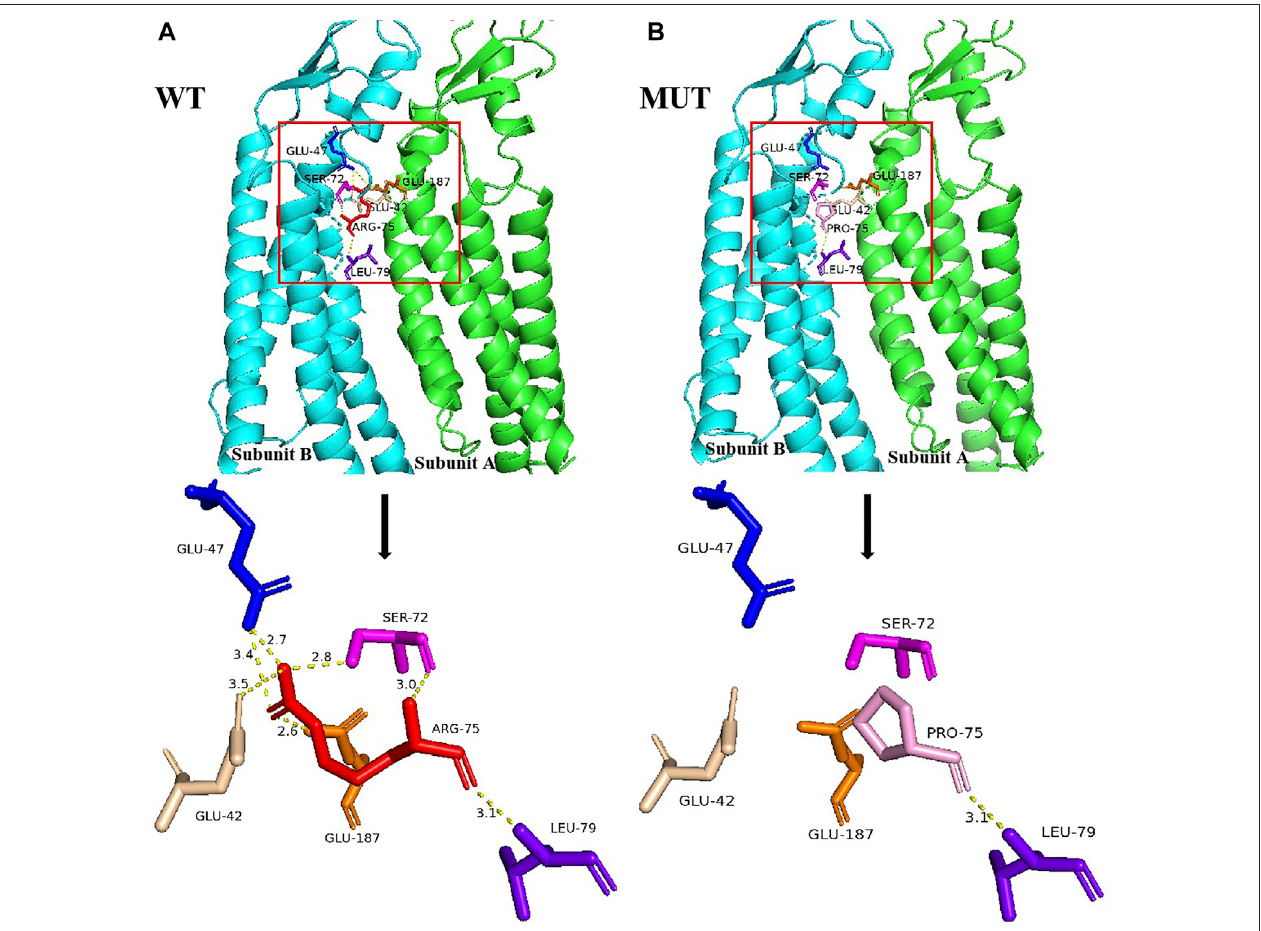
FIGURE 2 | Structural analysis of the GJB2 p.R75P variant. (A) Location of Arg75 and the nearby residues it interacts with, and the local spatial structure of the residues Arg75, Leu79, Ser72, and Glu47 in subunit B and Glu187 and Glu42 in subunit A. Hydrogen bonds are indicated as yellow dotted lines. Other subunits of Cx26 have been omitted for clarity. (B) Location of Pro75 and the nearby residues it interacts with, and the local spatial structure of the residues Pro75, Leu79, Ser72, and Glu47 in subunit B and Glu187 and Glu42 in subunit A. Hydrogen bonds are indicated as yellow dotted lines.